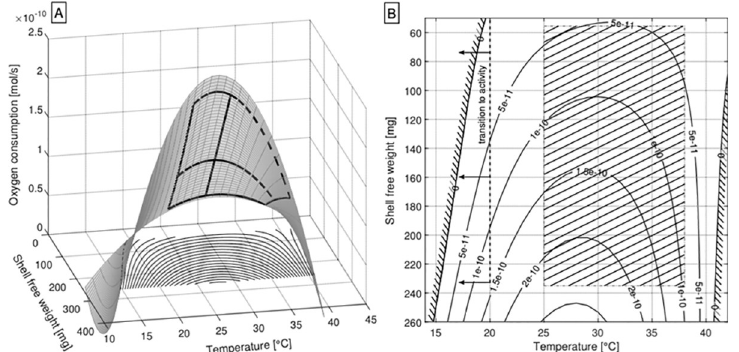
Fig 5. A: Response surface calculated for oxygen consumption vs. temperature and shell free weight. B: Two- dimensional plot of constant O 2 consumptions (isoboles) in a temperature vs. shell free weight diagram. Zero isoboles represent the theoretical limits (zero O 2 consumption) deduced by extrapolation. The hatched area shows the region covered by the measurements.